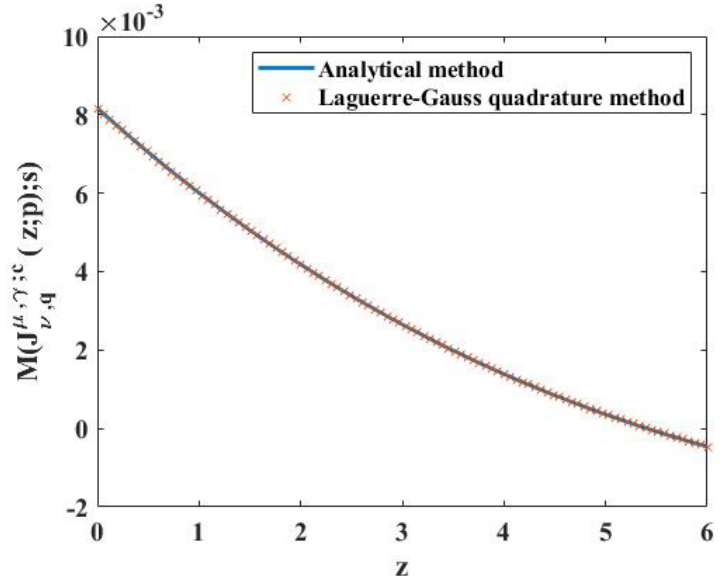
(cid:17) (cid:16) J µ , γ ; c ν , q ( z ; p ) ; s as a function of z from (7) and (24) with c=10, γ = 6, µ = 2,